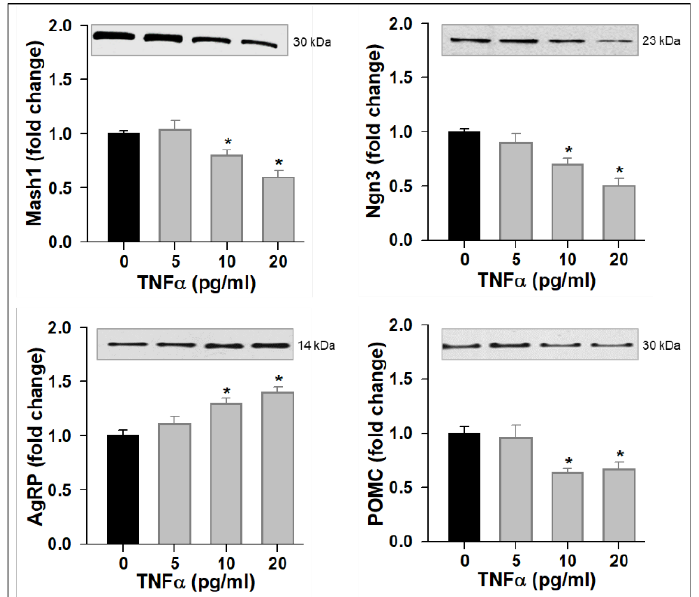
Figure 3. TNF α Suppresses Proneurogenic bHLH Genes and Alters Neuropeptide Expression. Hypothalamic NPCs were treated with various doses (5, 10, 20 pg/mL) of TNF α in differentiation medium for 24 h. Values are (Mean ± SEM of n = 4 independent experiments with each treatment performed in duplicate) normalized to untreated control cells and expressed as fold change. For protein expression, representative immunoblots are shown.* p < 0.05 vs. untreated cells.